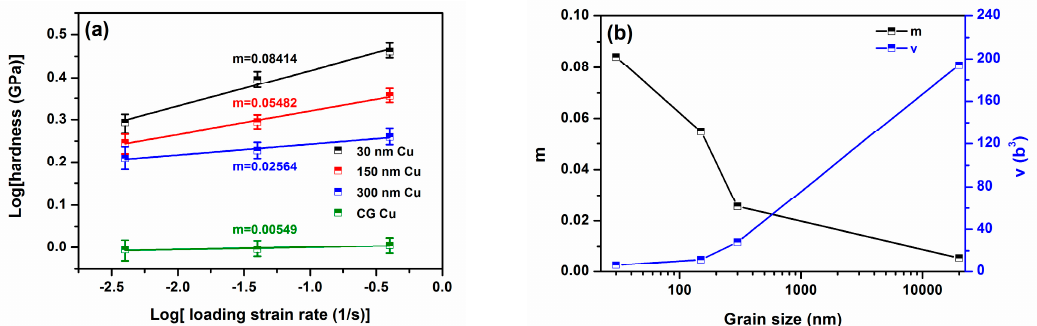
H  ) curves for measuring the m . ε L ) curves for measuring the m values of L . ε L of 0.4/s, 0.04/s, and 0.004/s at room temperature ( a );  of 0.4/s, 0.04/s, and 0.004/s at room L